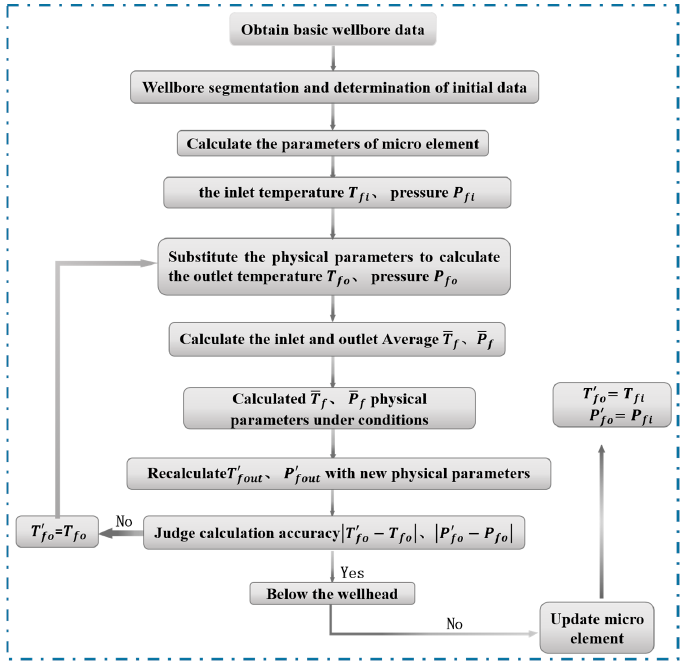
Figure 4. The mathematical model calculation process. Table 1. Basic parameters of case well.